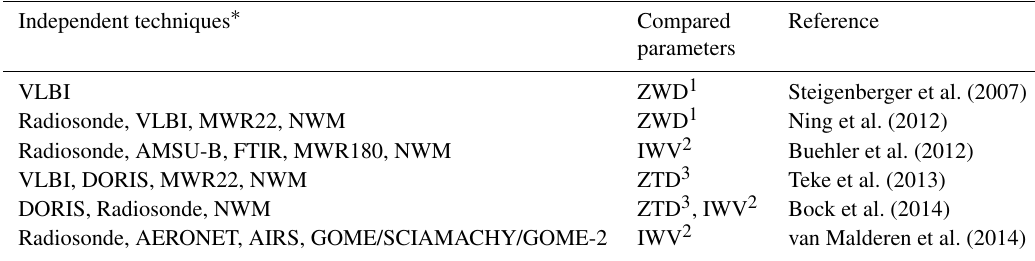
Table 3. Selected comparisons of GNSS water vapour related studies. Independent techniques